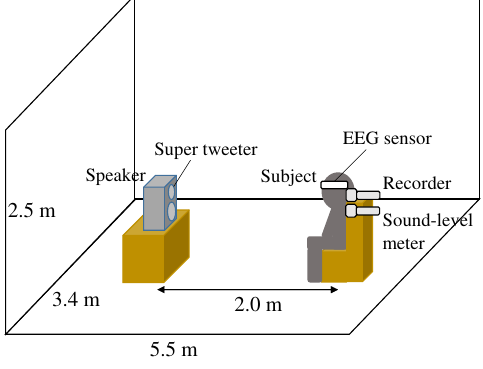
Figure 2. Measurement